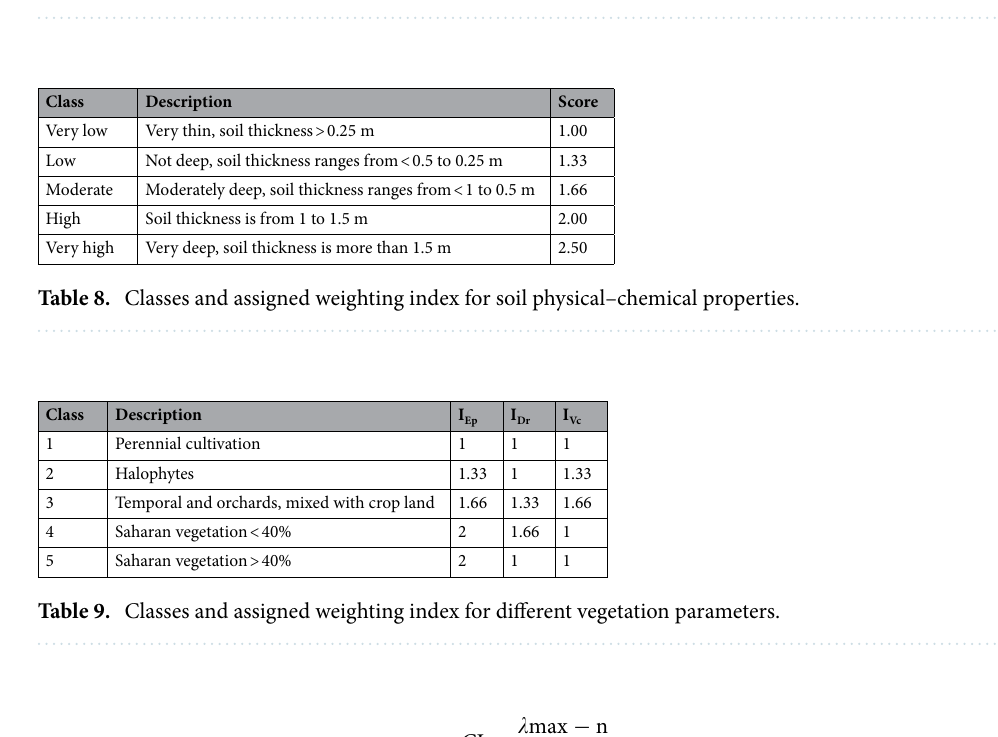
Table 7. Classes, and assigned weighting index for parent material.